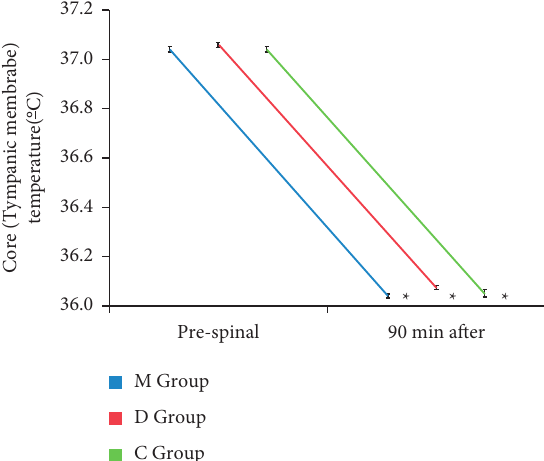
Figure 4: Variations in core temperature ( ° C) after 90 minutes of subarachnoid block in comparison to the prespinal (baseline) values. ∗ Statistically significant. Table 2: Incidence, grades, and treatment of postspinal anesthesia shivering among the studied groups. Time